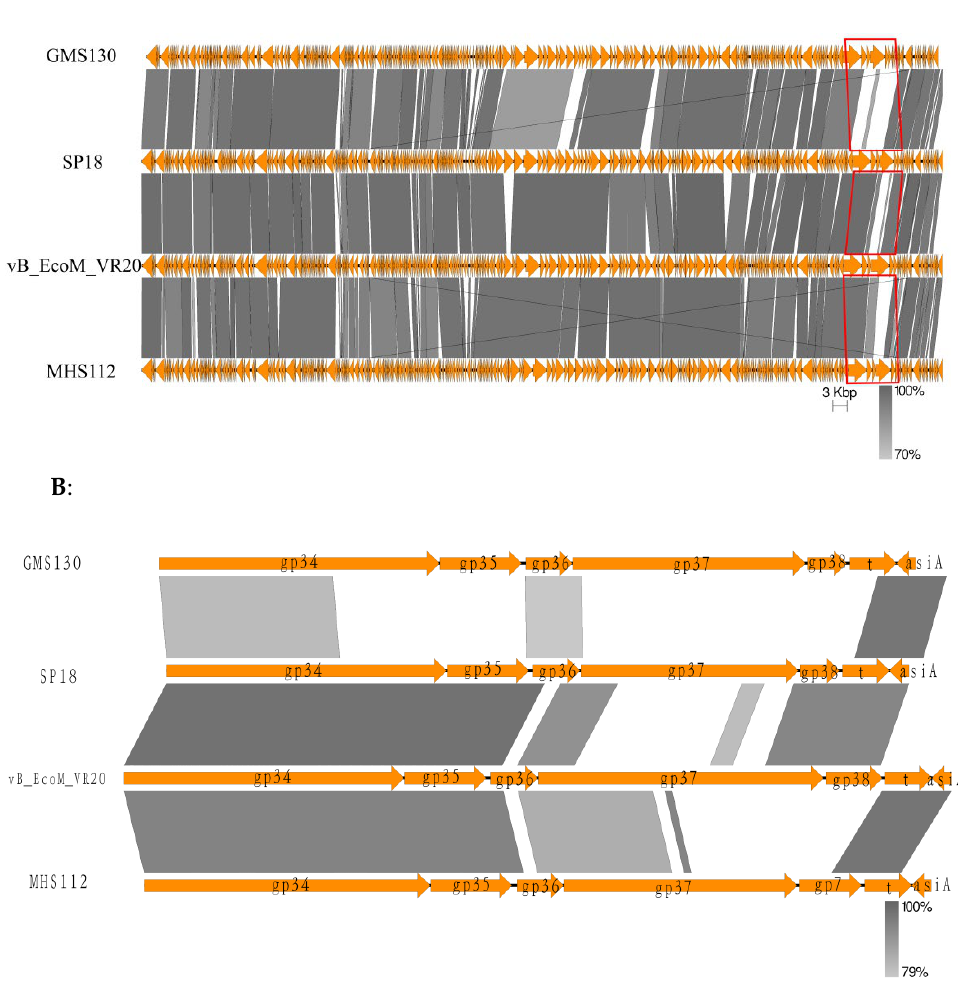
Figure 3. Comparative genomic analysis of bacteriophages MHS112 and GMS130 with bacteriophages SP18 and vB_EcoM_VR20. ( A ) Whole genome alignment of four phage genomes. The red frame indicates a small nonmatched gene cluster. ( B ) Organisation of the small nonmatched gene cluster from the red frame in ( A ).